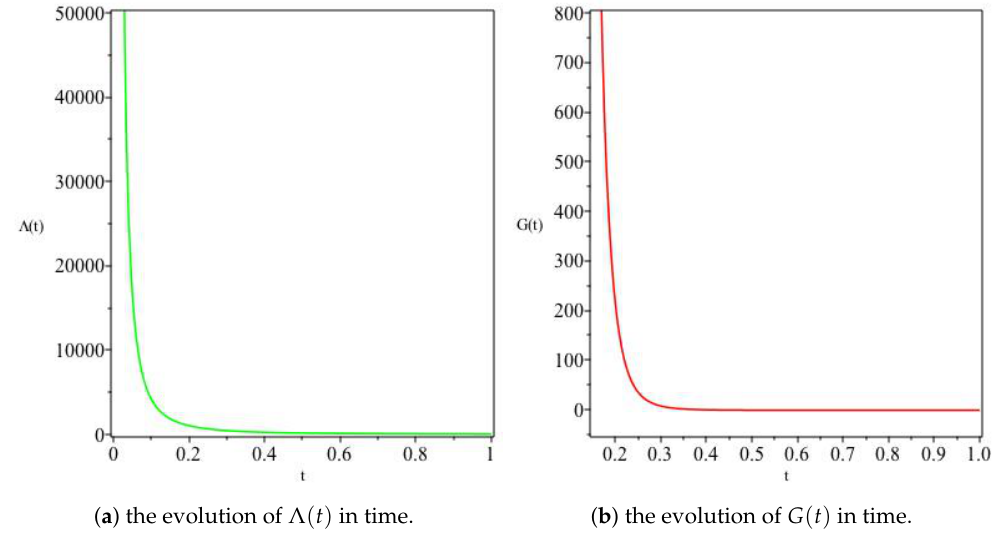
Figure 11. The variation of Λ and G for Model II. Here both Λ and G decrease in time, the former faster than the